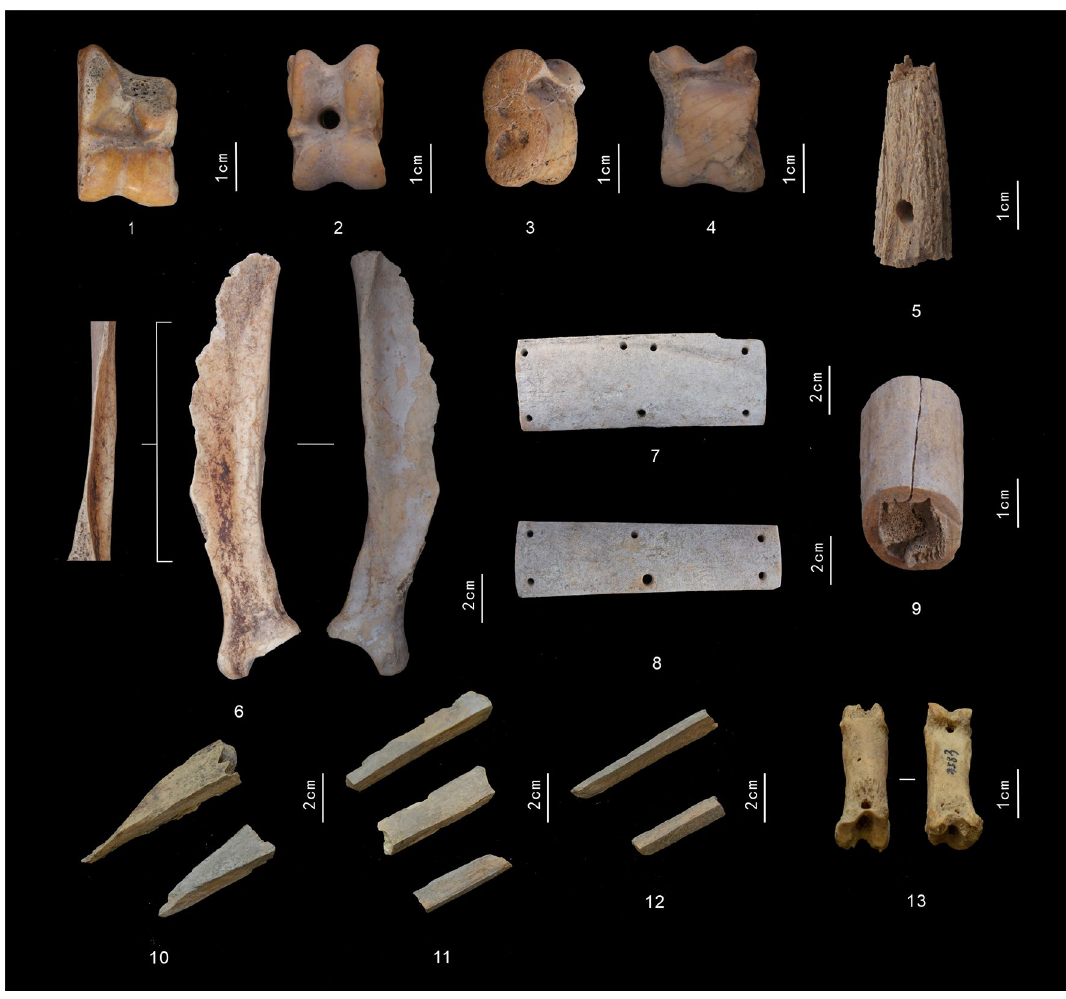
Figure 3. Worked bones in Shirenzigou F2: ( 1–4 ) Astragali; ( 5 ) Horn bit; ( 6 ) Bone knive; ( 7, 8 ) Plaques; ( 9 ) Antler unfinished product; ( 10–12 ) Bone unfinished products; ( 13 ) Ornament. Photograph credit: Y.